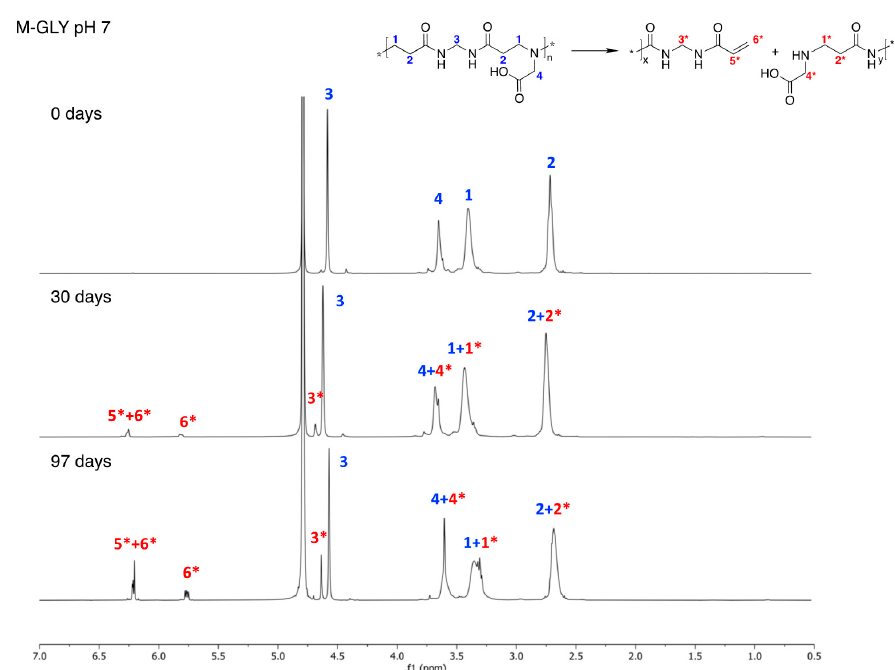
Figure 1. 1 H-NMR spectra of M-GLY obtained in D 2 O at pH 4.0 at different times using a 400 MHz Avance Brüker spectrometer. Concentration of the repeat unit 43.6 μ M.